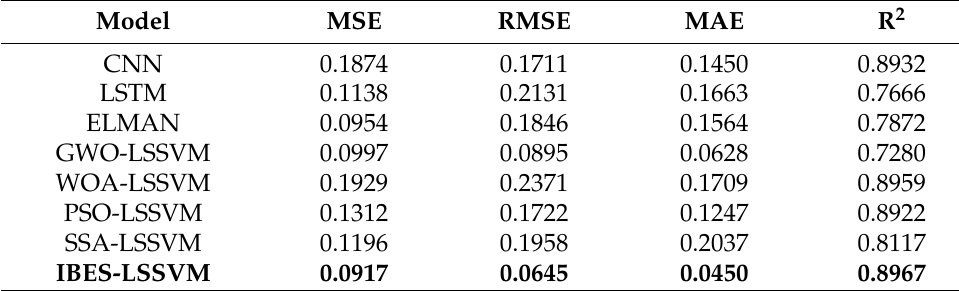
Figure 18. 90% of NH3-N. Table 10. Predictive index of